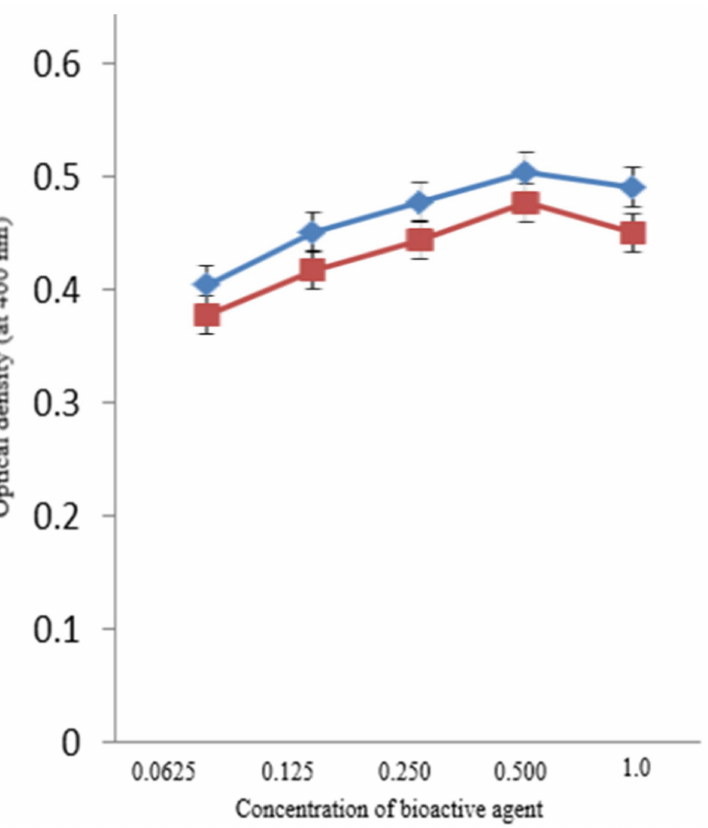
Figure 4. Activity of β -glucosidase with the synthesized AgNPS ( (cid:3) ) and BAC-coated AgNPs ( (cid:3) ). However, there was no further change of activity beyond this concentration. Table 1 suggests the zone of inhibition of AgNPs and BAC–AgNPs against E. coli, B. subtilis, P. aeruginosa , and S pneumoniae at 0.25 and 0.50 mM concentration of these bioactive agents, respectively. ZOI was 3.45 cm and 3.56 cm for AgNPs and BAC–AgNPs at 0.25 mM of these bioactive agents, respectively, against E. coli . Table 1. Zone of inhibition (diameter, cm) of antibacterial test of AgNPs and Benzalkonium chloride (BAC)-coated AgNPs. E. coli B. Concentration (mM)